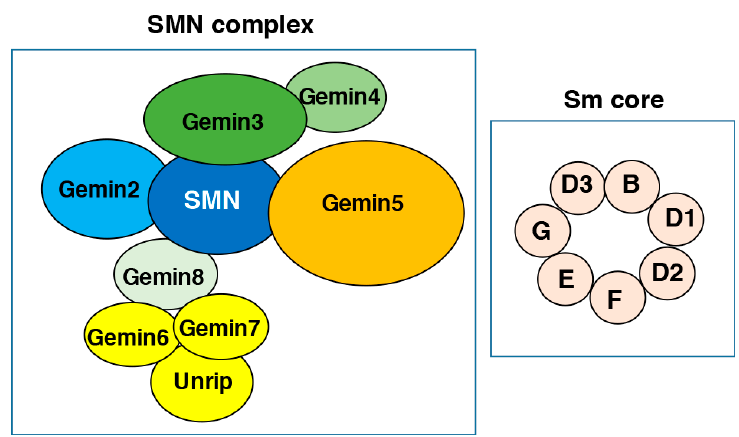
Figure 1. Simplified diagram of the survival of motor neuron (SMN) complex and the Sm core. The individual members of the SMN complex (SMN, Gemin2-8 and unrip) as well as the Sm proteins are depicted according to their interaction pattern. See text for details.